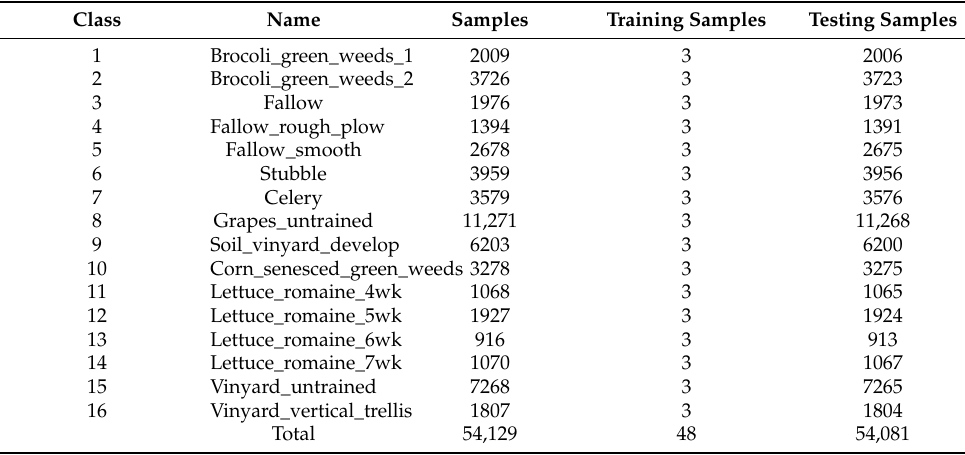
Table 3. Land cover classes and the numbers of samples in the SA data